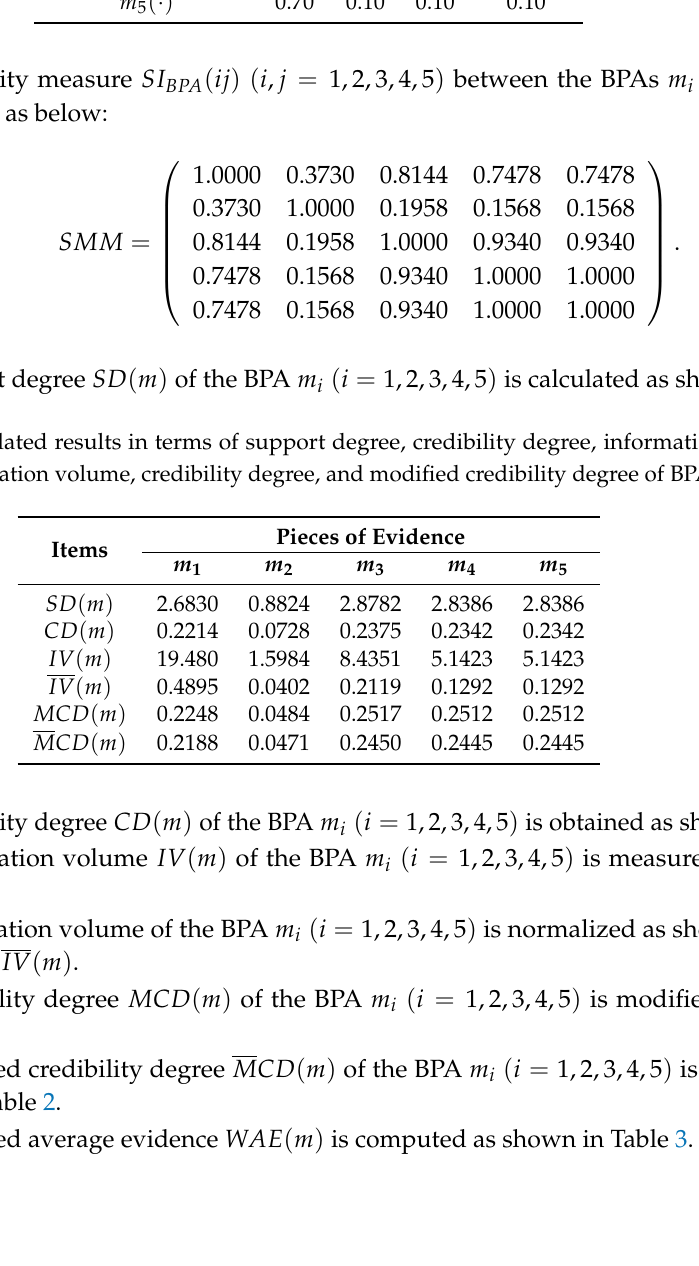
Pieces of Evidence